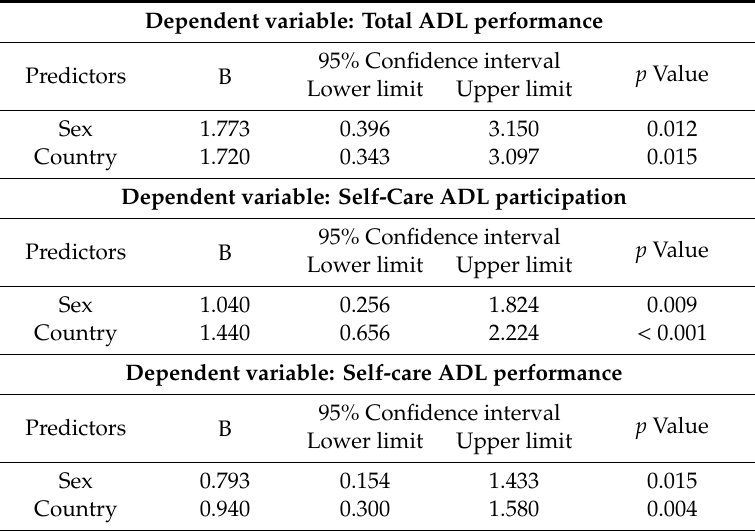
Table 4. Linear regression models for total ADL performance, self-care ADL participation and self-care ADL performance (stepwise method) ( n =